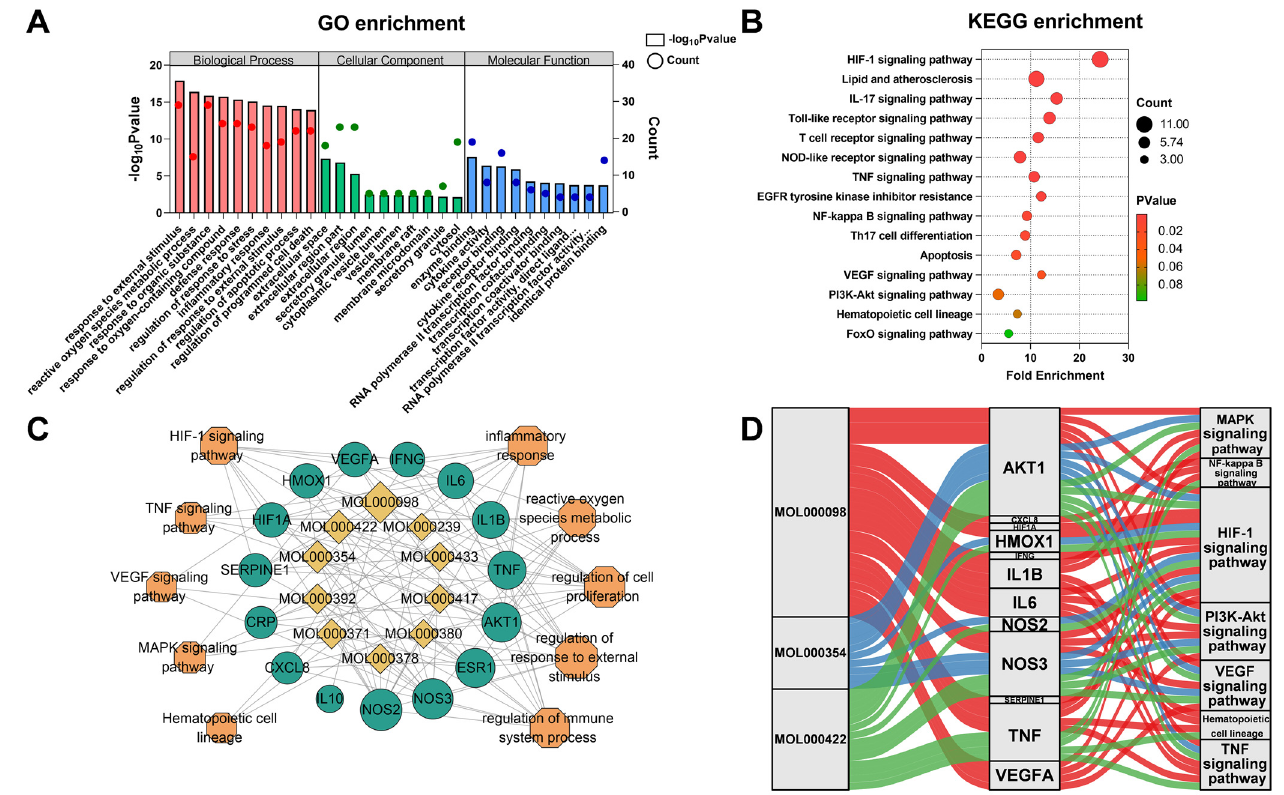
Figure 6. Pathway enrichment analysis. ( A , B ) Enrichment analysis of GO ( A ) and KEGG ( B ) pathways for common targets. ( C ) GO-BP and KEGG pathway enrichment analysis of core targets. ( D ) Component-core-target-pathway of Sankey diagram.